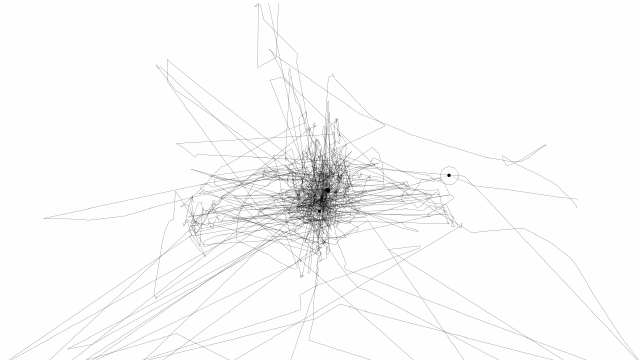
Figure 14. Gaze movement of a participant during a typical play-through of Zombie Runner. It can be observed that the player spends most of the time gazing at the central region of the screen.